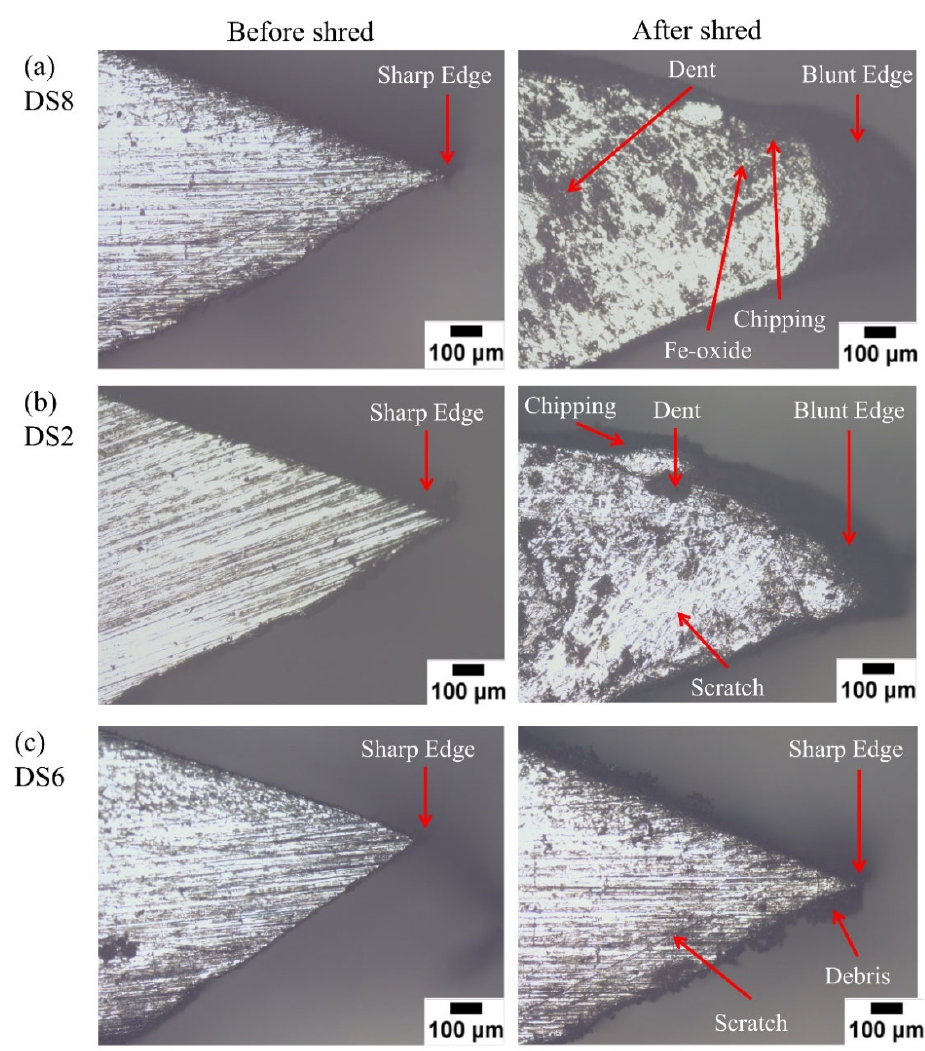
Figure 9. Optical microscope images of the double-edge blades in spiral orientation, before and after shredding of PET plastic: ( a ) DS8, ( b ) DS2, ( c ) DS6.